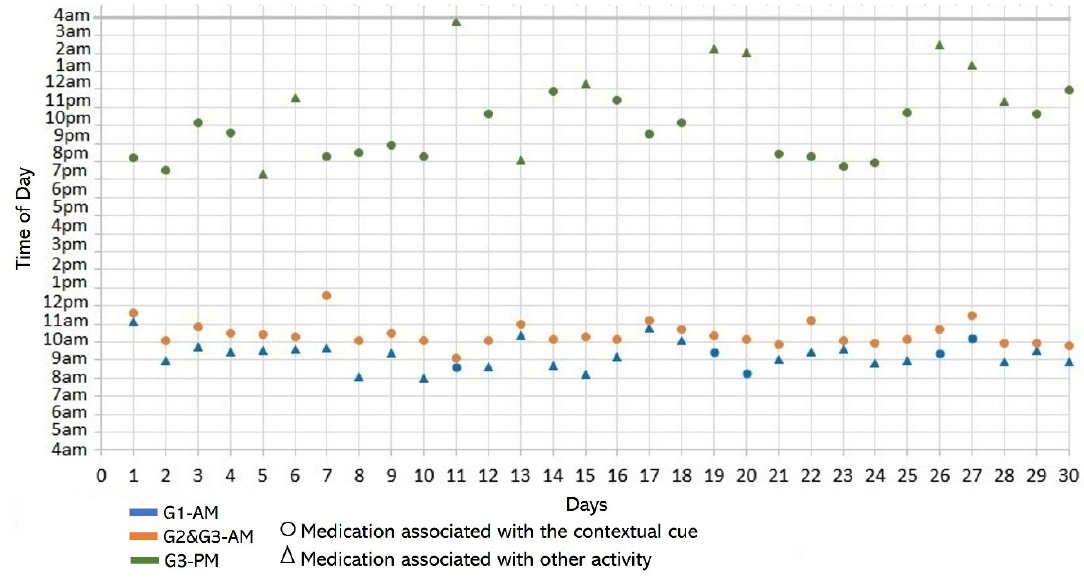
Figure 7. Medication behavior of S3 shows the time of day in which the medication episodes (G1-AM, G2&G3-AM, and G3-PM) were conducted and whether they were associated with the activities set as contextual cues.